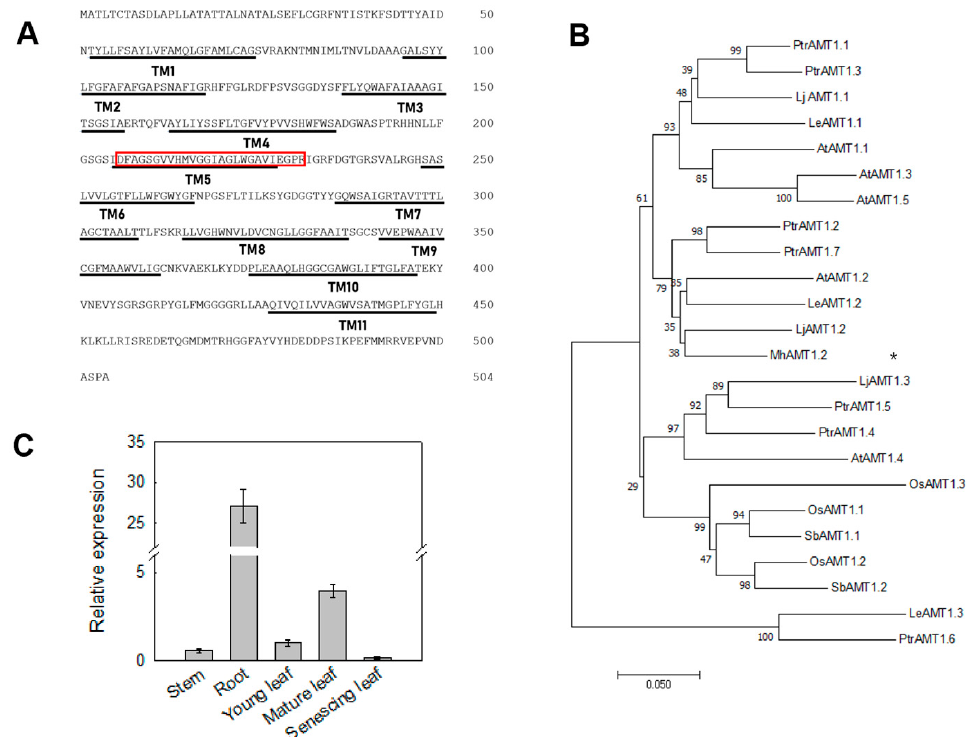
Figure 5. Phylogenetic analysis, protein sequence analysis of MhAMT1;2, and tissue-speci fi c expres- sion of its coding gene. ( A ) Predicted transmembrane (TM) domains in MhAMT1;2 . TM domains were underlined. The AMT-speci fi c domain was boxed in red. ( B ) phylogenetic tree construction of known AMT1 members in plants. MhAMT1;2 was indicated with an asterisk. Scale bar stands for